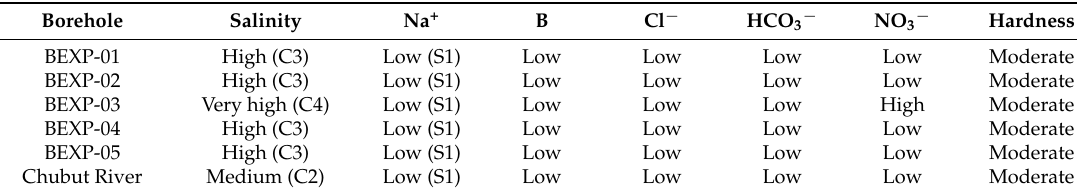
Figure 6. Classification of water quality for irrigation purposes in the study area (after [40]). Table 4. Content of major elements that determine the suitability of waters for